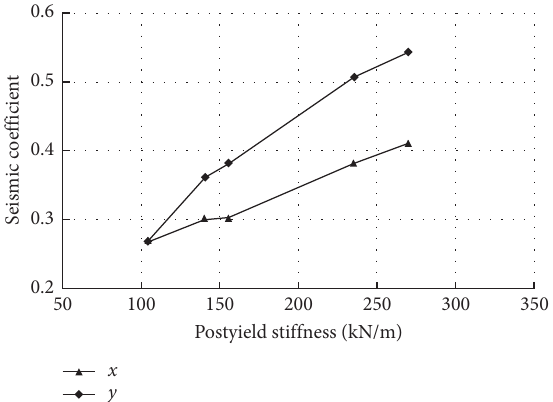
Figure 24: Horizontal displacement related to equivalent hori- zontal